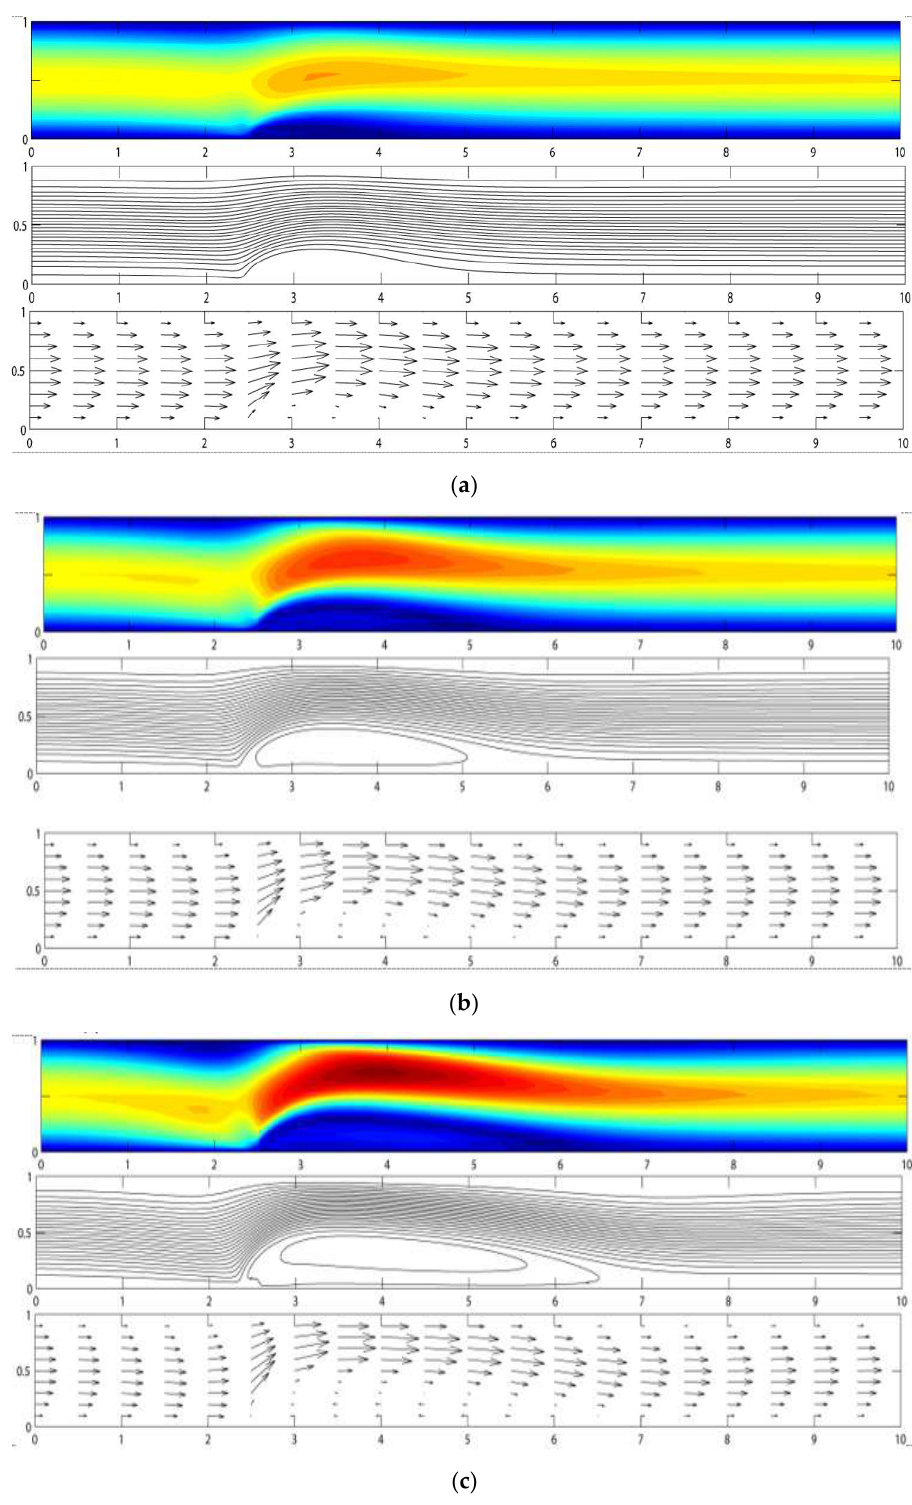
Figure 2. Velocity contour, stream function, and velocity direction for biomagnetic flow subjected to magnetic field strength, 𝐵 (cid:3042) (cid:3364)(cid:3364)(cid:3364) , of ( a ) 2 T; ( b ) 4 T; and ( c ) 8